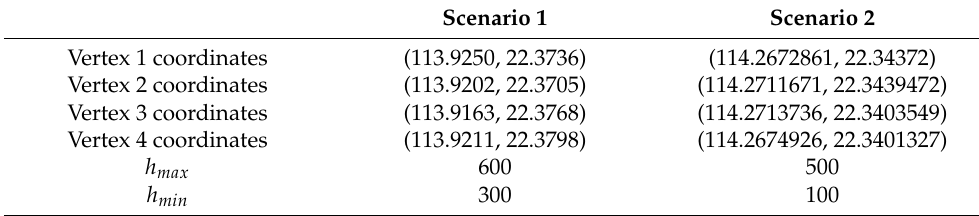
Table 3. Parameters of the simulation